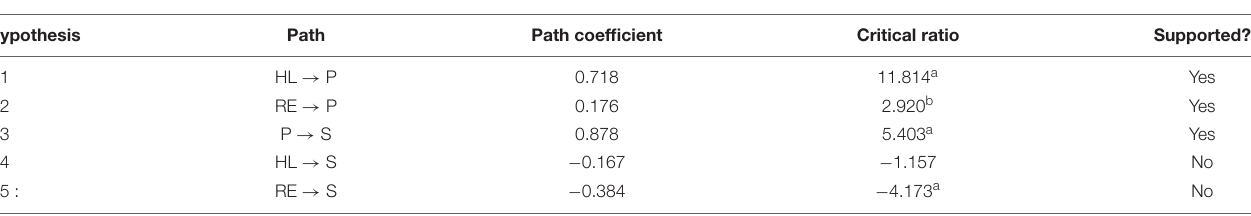
TABLE 5 | Hypothesis testing based on the structural equation modeling (N = 703).